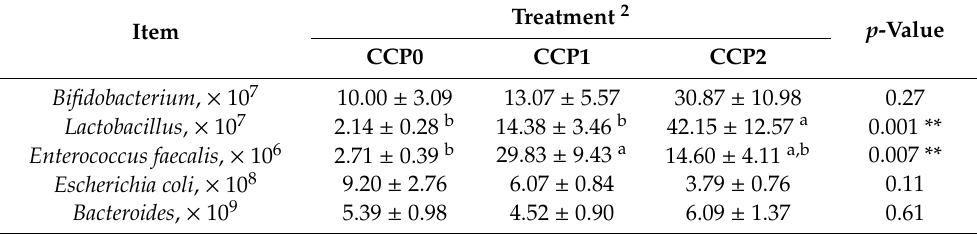
Table 7. E ff ect of CCP on caecum microorganisms of broilers (cfu / g, ± SEM 1 ) at 50